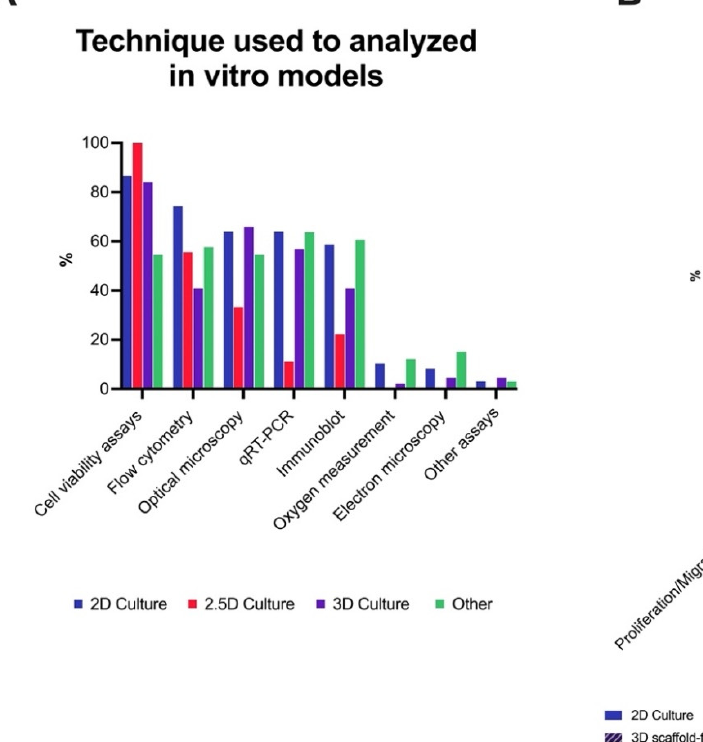
Table 1. Significant correlations between techniques used to analyze in vitro models and downstream analysis (PCC > 0.4).